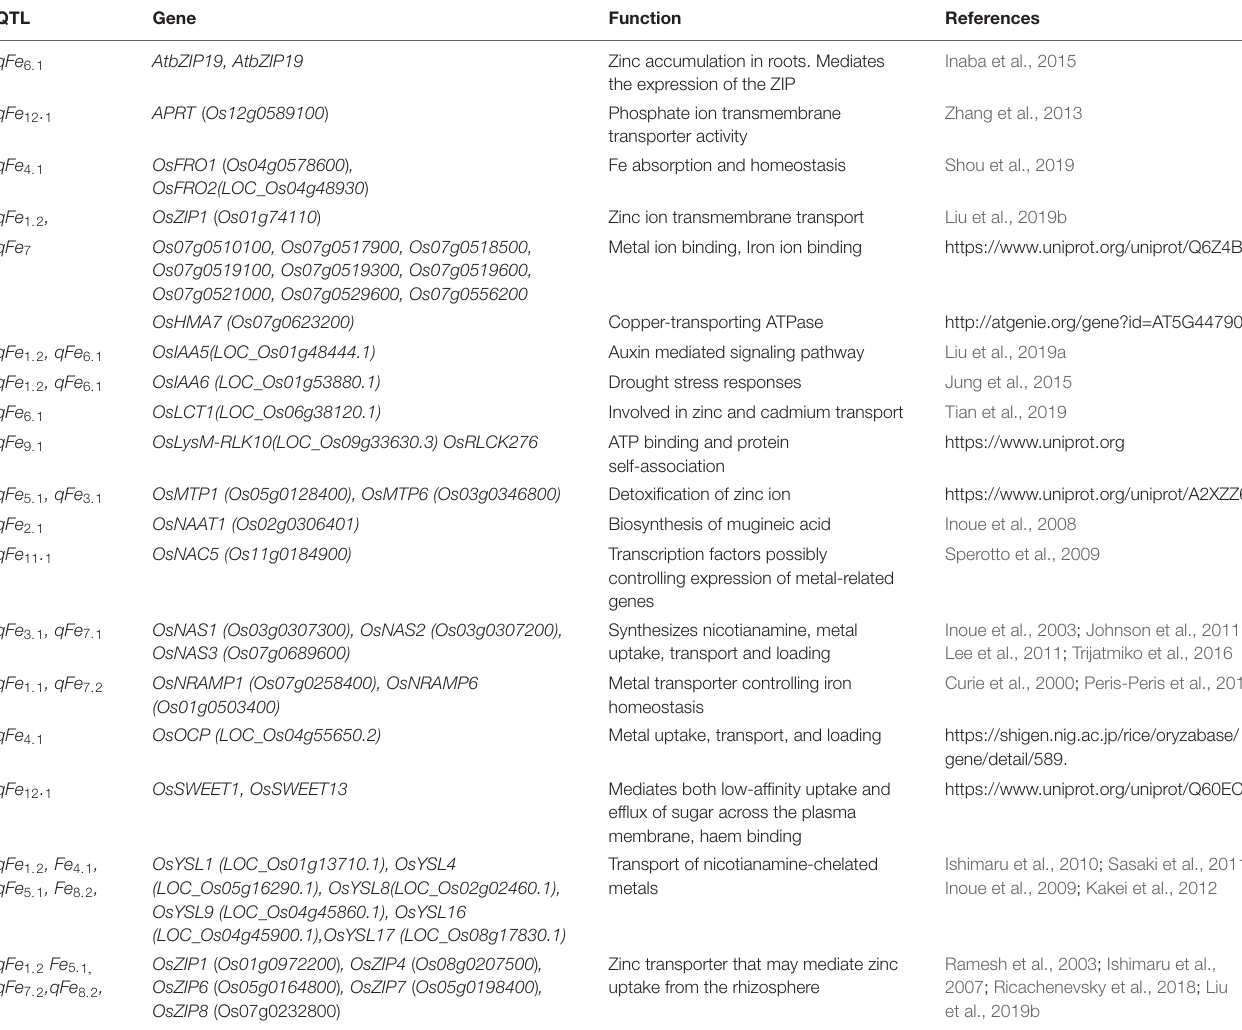
TABLE 2 | Biological functions of QTL linked candidate genes for Fe